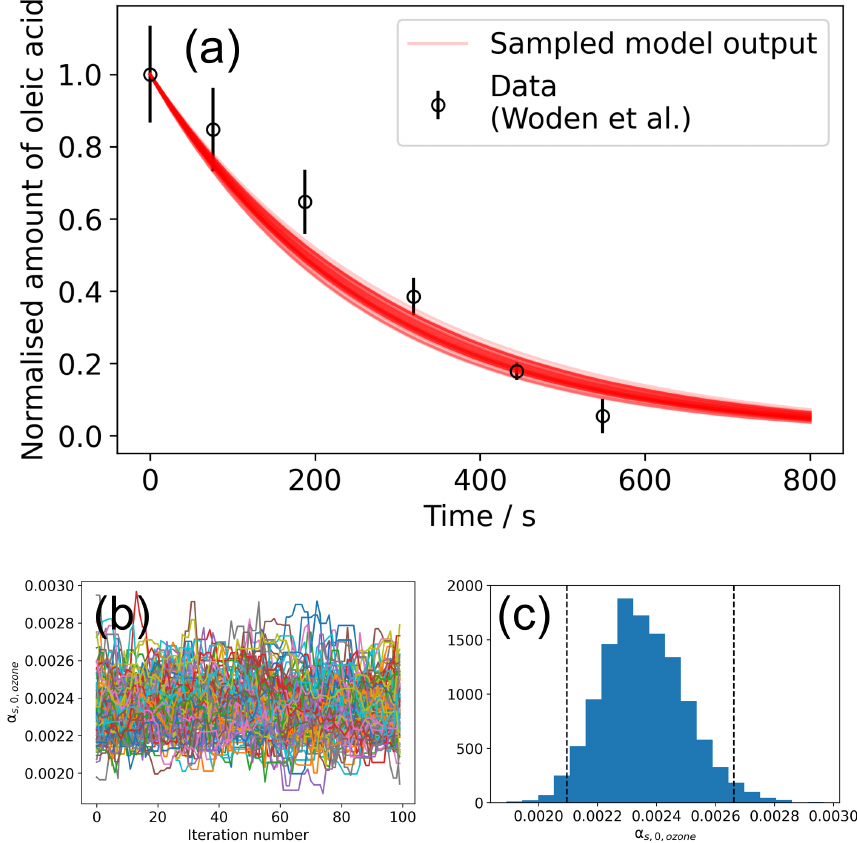
Figure 4. Result of the global optimisation MCMC sampling procedure. (a) Total of 200 model outputs sampled from the MCMC sampling procedure, showing the range of model outputs consistent with the data. (b) A plot of α s , 0 , ozone vs. iteration number of the MCMC algorithm for a converged set of walkers (Markov chains). In total, 100 samples were discarded (burn-in step) before chains converged. (c) The histogram of α s , 0 , ozone values derived from the walkers presented in panel (b) . Vertical dashed lines represent the interval in which 95 % of the data lie.